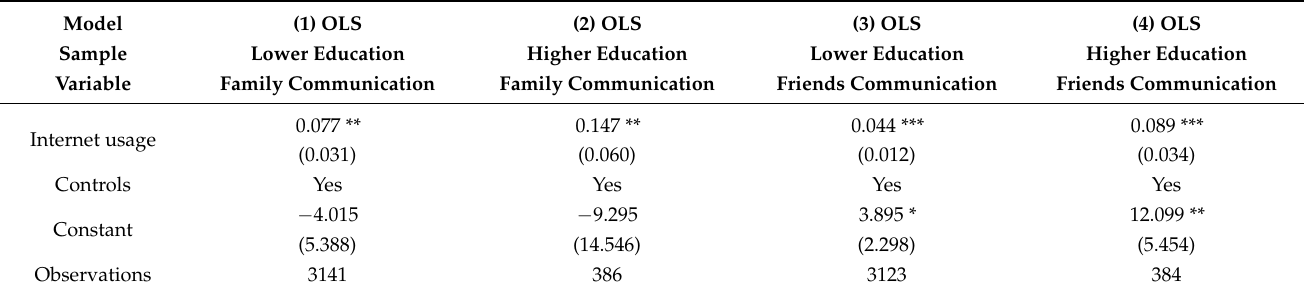
Table 13. Heterogeneity analysis, in terms of education level.